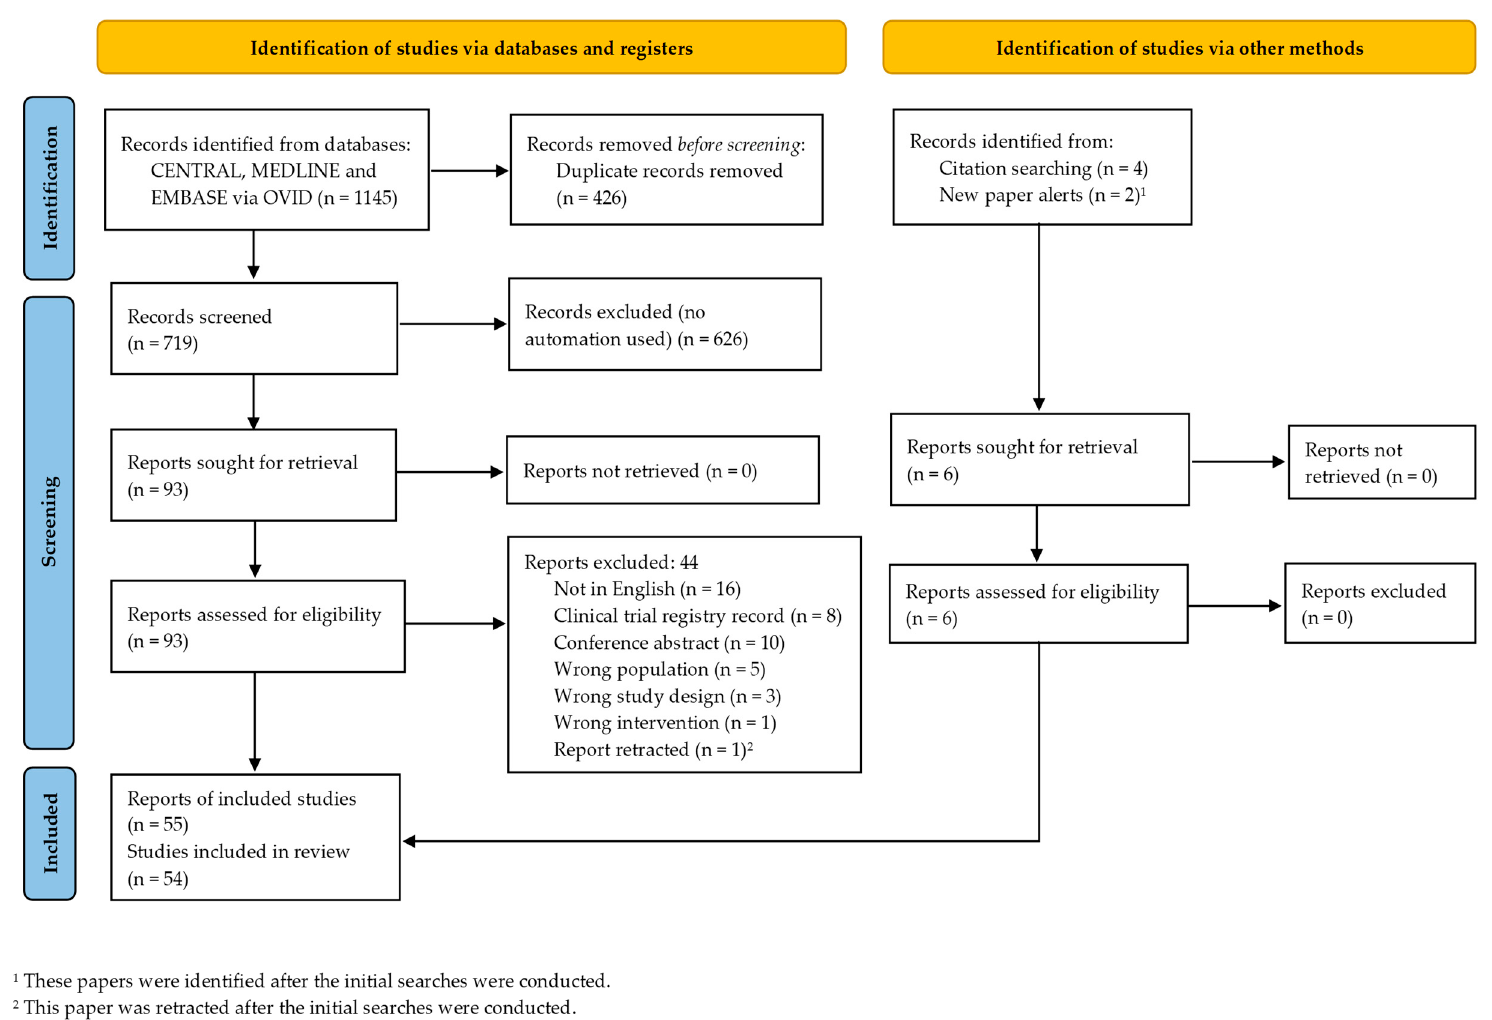
Figure 1. PRISMA flow diagram of study selection.